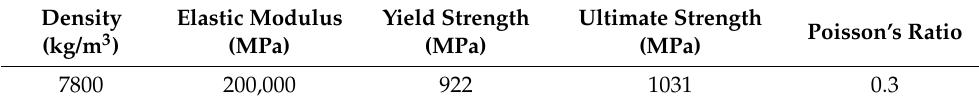
Figure 4. Geometric part—load sphere.